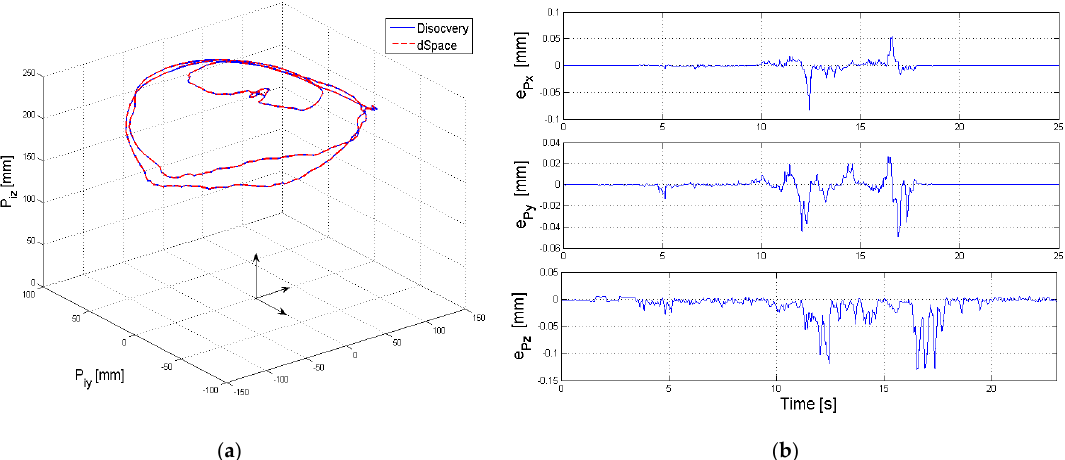
Figure 10. Trajectory of the end effector (4th module) ( a ) 3D representation ( b ) absolute positioning error along axis O x , O y and O z for the 4th module. Sensors 2022 , 22 , x FOR PEER REVIEW